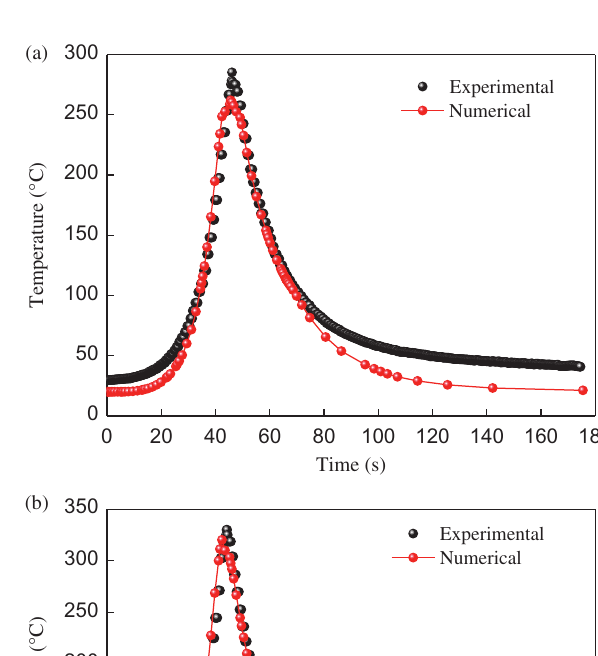
Figure 4: Thermal boundary conditions of FSW.